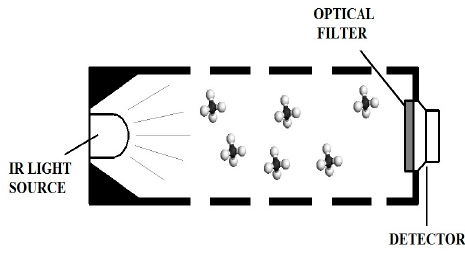
Figure 5. Scheme of NDIR-type sensor.